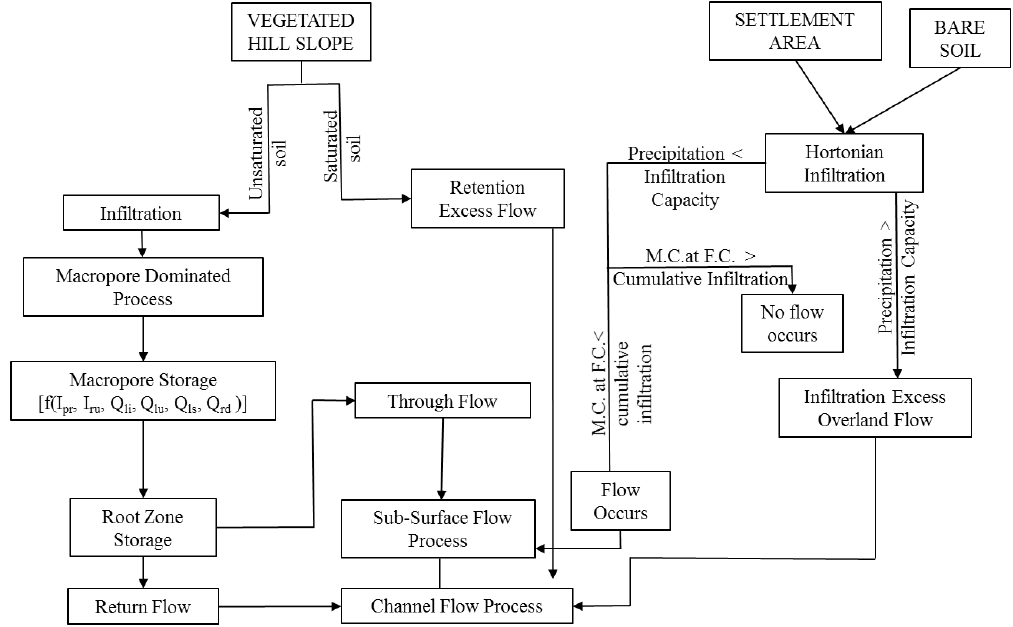
Figure 6. Conceptual flow chart of the hillslope hydrological model. M.C.: Moisture content, F.C.: Field capacity.